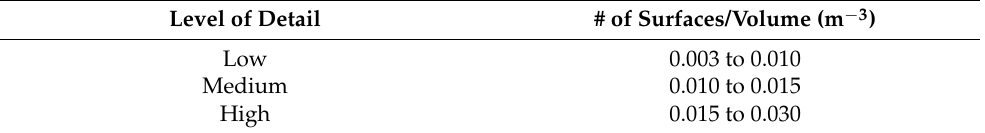
Table 1. Planes to volume detail ratio